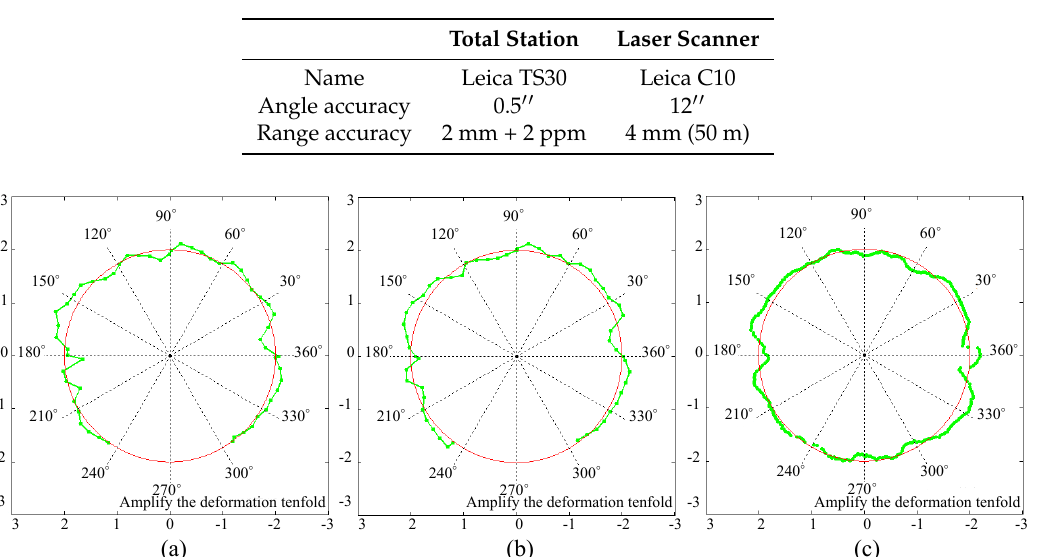
Figure 16. The profiles fitted by the data acquired in the experiments: ( a ) denotes the profile fitted by the first set of data collected by the station as a whole; ( b ) denotes the profile fitted by the second set of data collected by the station as a whole; ( c ) illustrates the profile fitted by the point cloud scanned by the TLS.